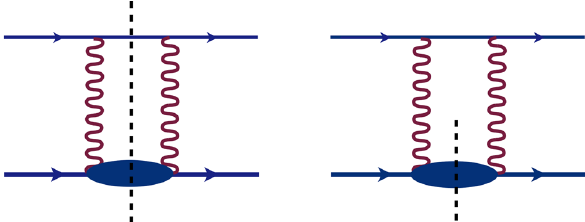
Fig. 6 Forward elastic lp scattering with a cut of both fermion lines ( left panel ) and with a cut of the nucleon line only ( right panel )